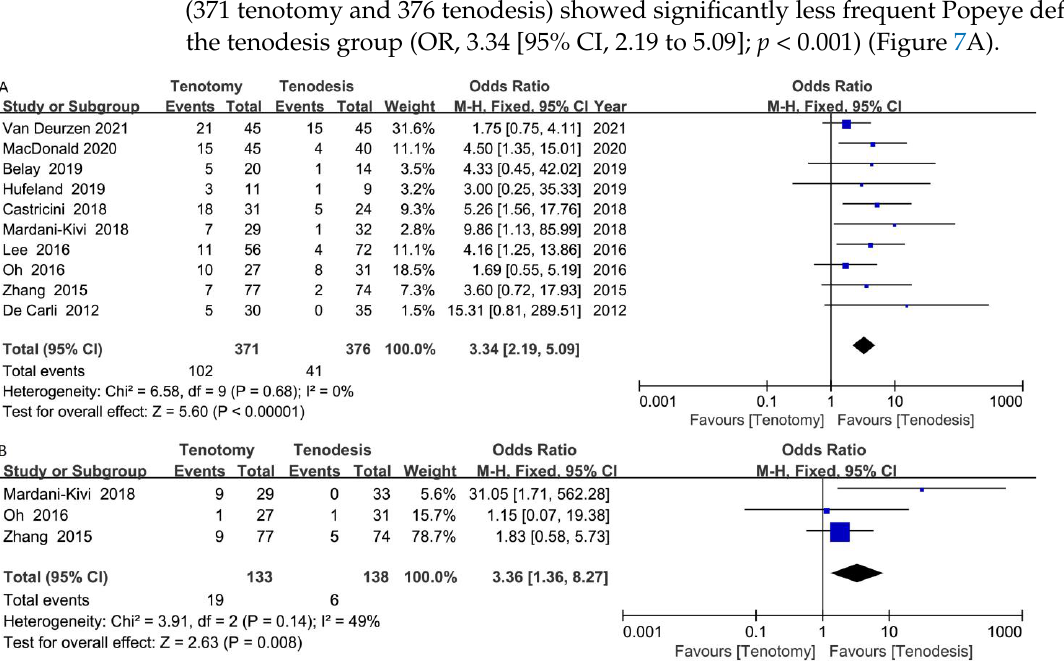
Figure 6. Meta-analysis of the ( A ) American Shoulder and Elbow Surgeons (ASES) score; ( B ) Simple Shoulder Test (SST) score. Green symbol: mean difference value; Black symbol: result of meta-anal- ysis.